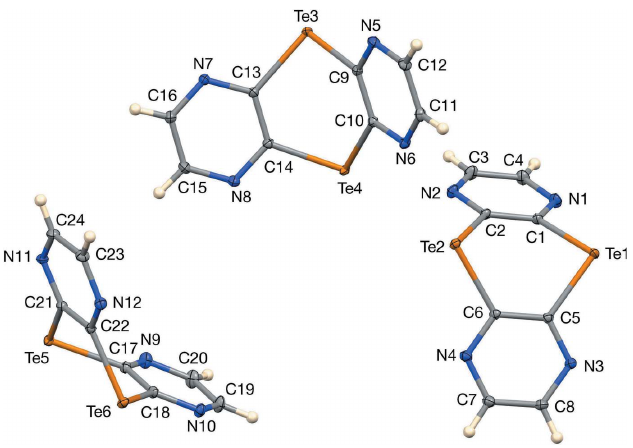
Figure 1 The asymmetric unit of [1,4]ditellurino[2,3- b :5,6- b 0 ]dipyrazine with 50% ellipsoids.